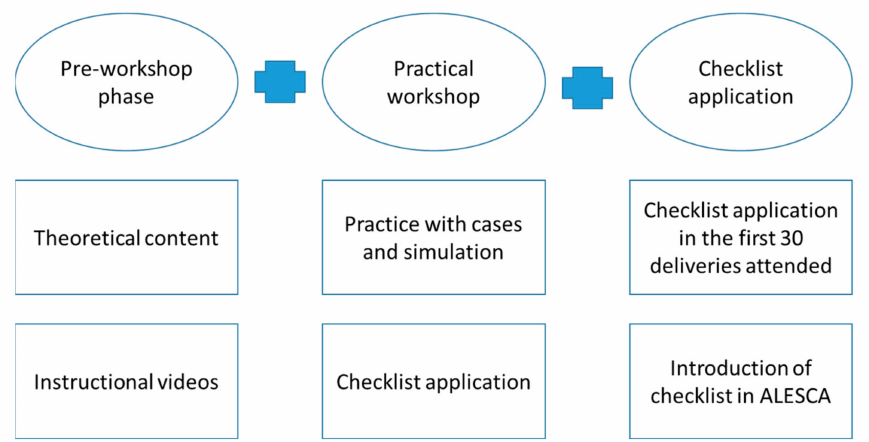
Figure 1. SW-EVD phases. Each of the activities to be performed by the gynecology and obstetrics residents in each phase is